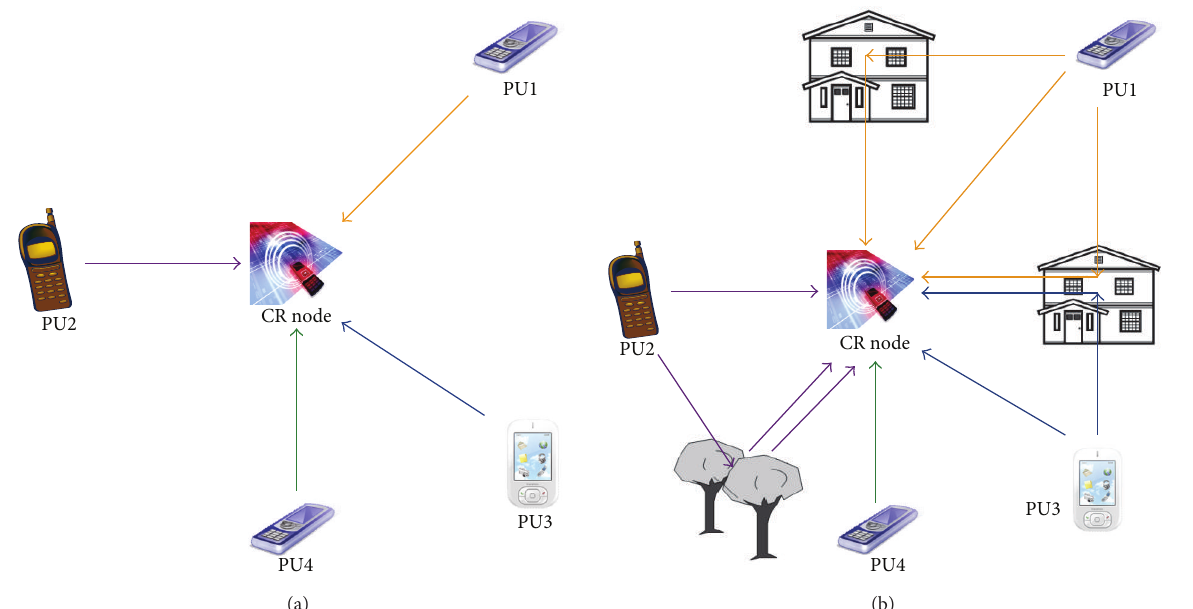
Figure 7: Cognitive radio in two sensing scenarios: LoS (a) and more realistic multipath (b).